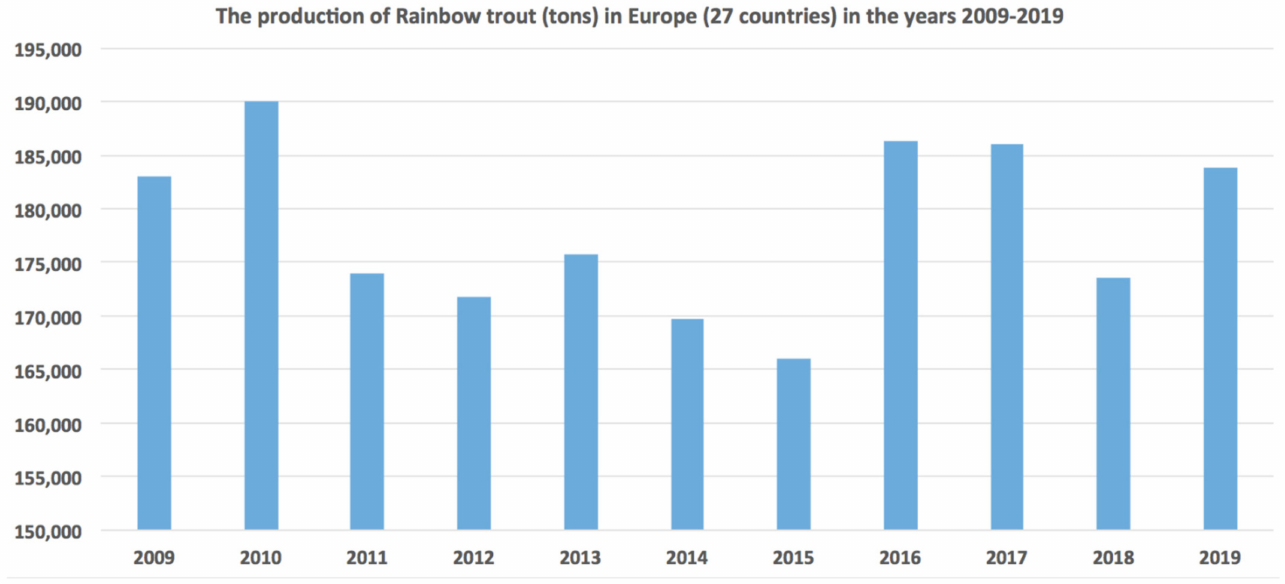
Figure 2. Popular countries with significant production of rainbow trout (tons) in the years 2009–2019 (EUMOFA 2020–2021; EUROSTAT; FEAP 2014–2019).